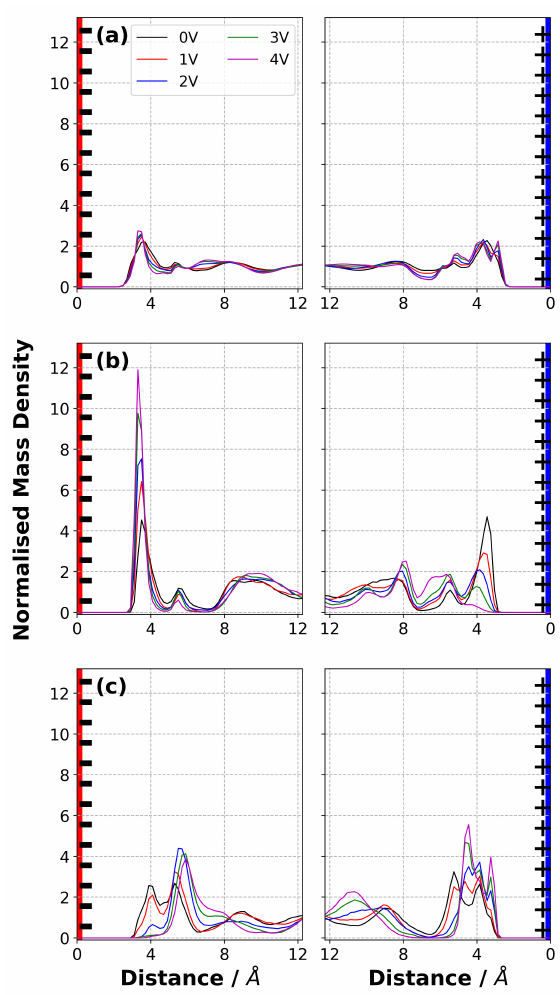
Figure 6. Average normalised mass density distribution of ( a ) [C 2 mim][NTf 2 ], ( b ) [C 2 mim] + and ( c ) [NTf 2 ] − at 294 K at various ∆Ψ . The first and second columns represent the EDL in the vicinity of negative electrode and positive electrode,